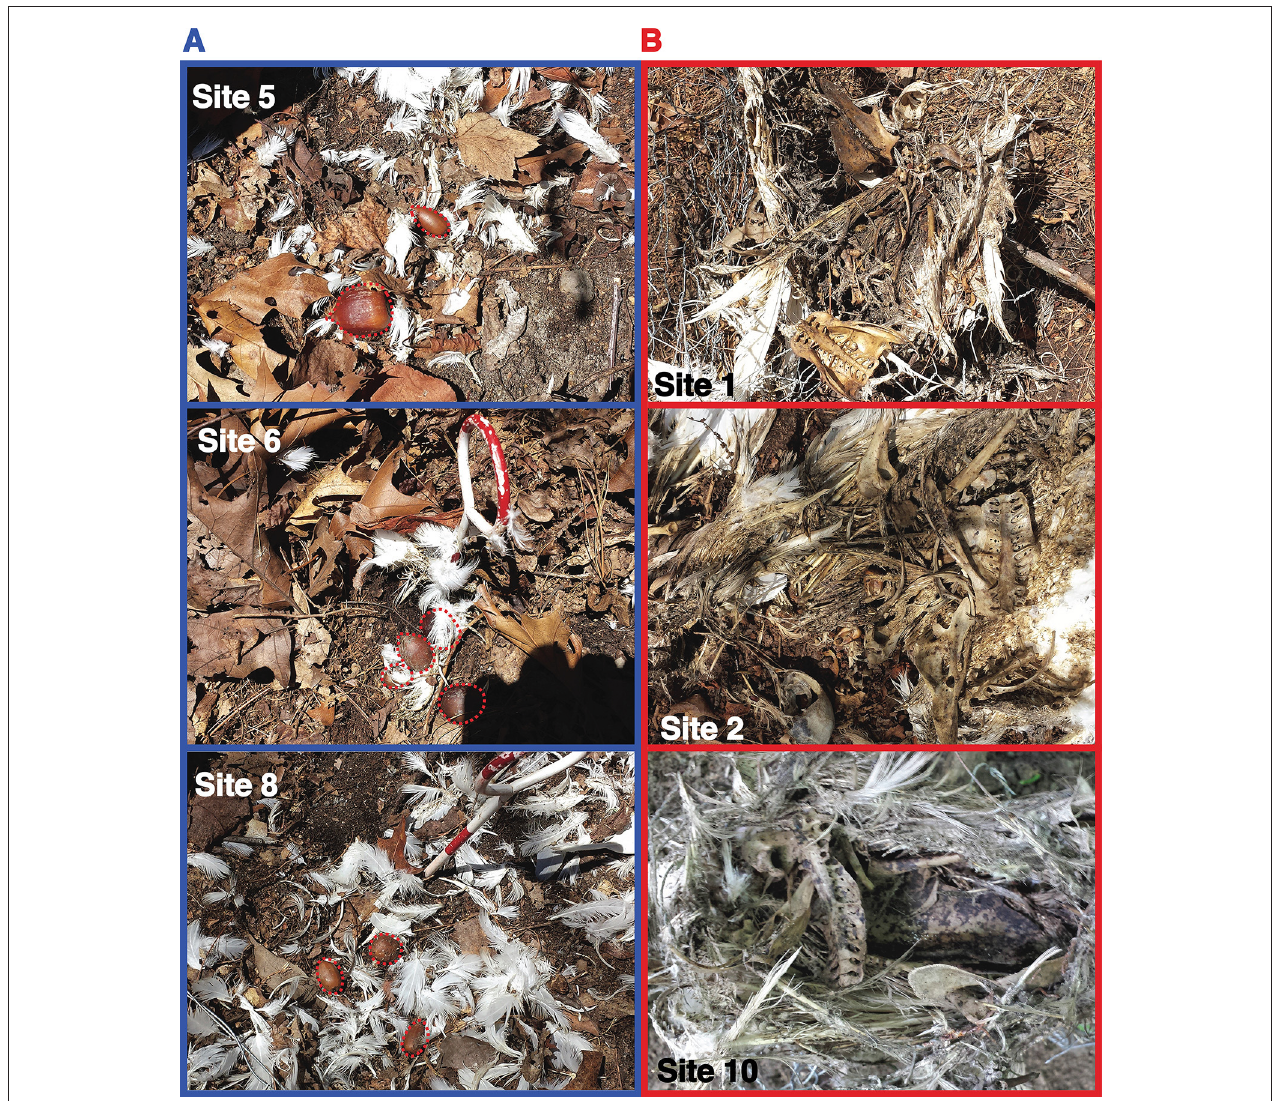
FIGURE 3 | (A) Examples of post-mortem released acorns from staked carcasses in blue inset images. Acorns are outlined in dashed red-line. (B) Examples of caged-carcass decay in red inset